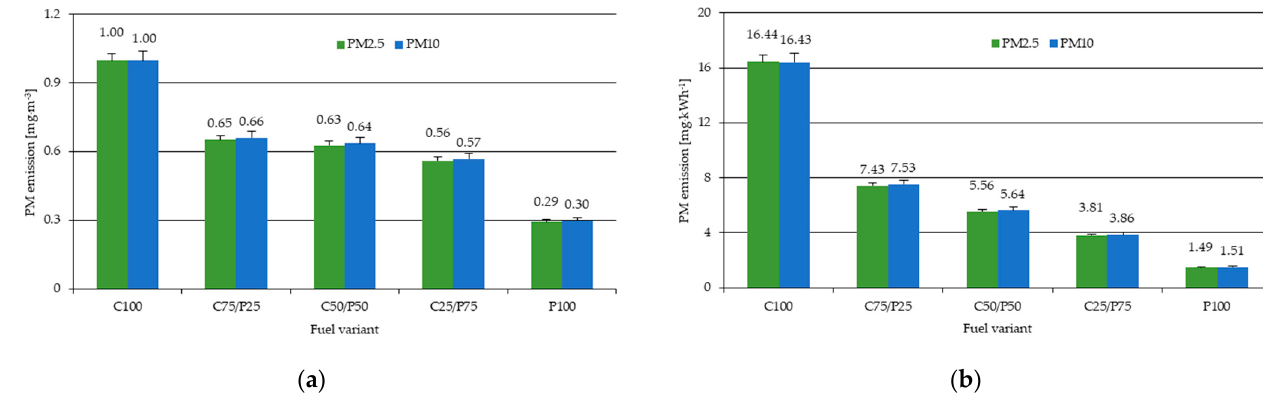
Figure 9. PM emission per ( a ) 1 m 3 exhaust gas; ( b ) 1 kWh thermal energy.